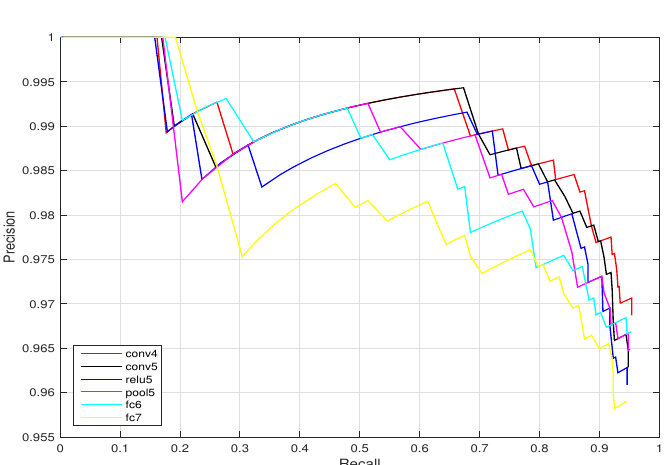
Figure 14. Precision-recall curves for the UTBM-2 data set considering different ConvNet layers ( d s =